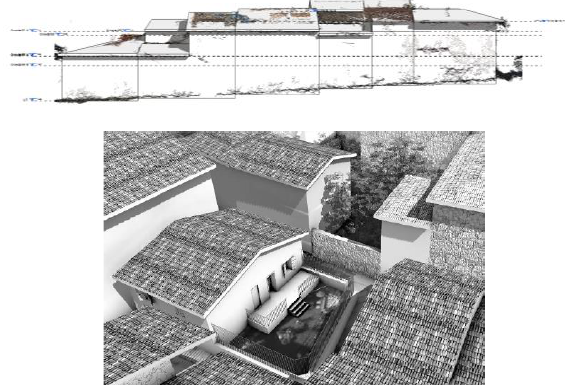
Figure 7. Examples of analysis of eaves, ridges and ground lines from building clouds, and corresponding modelling according to LoD 300 in the evacuated residential area.